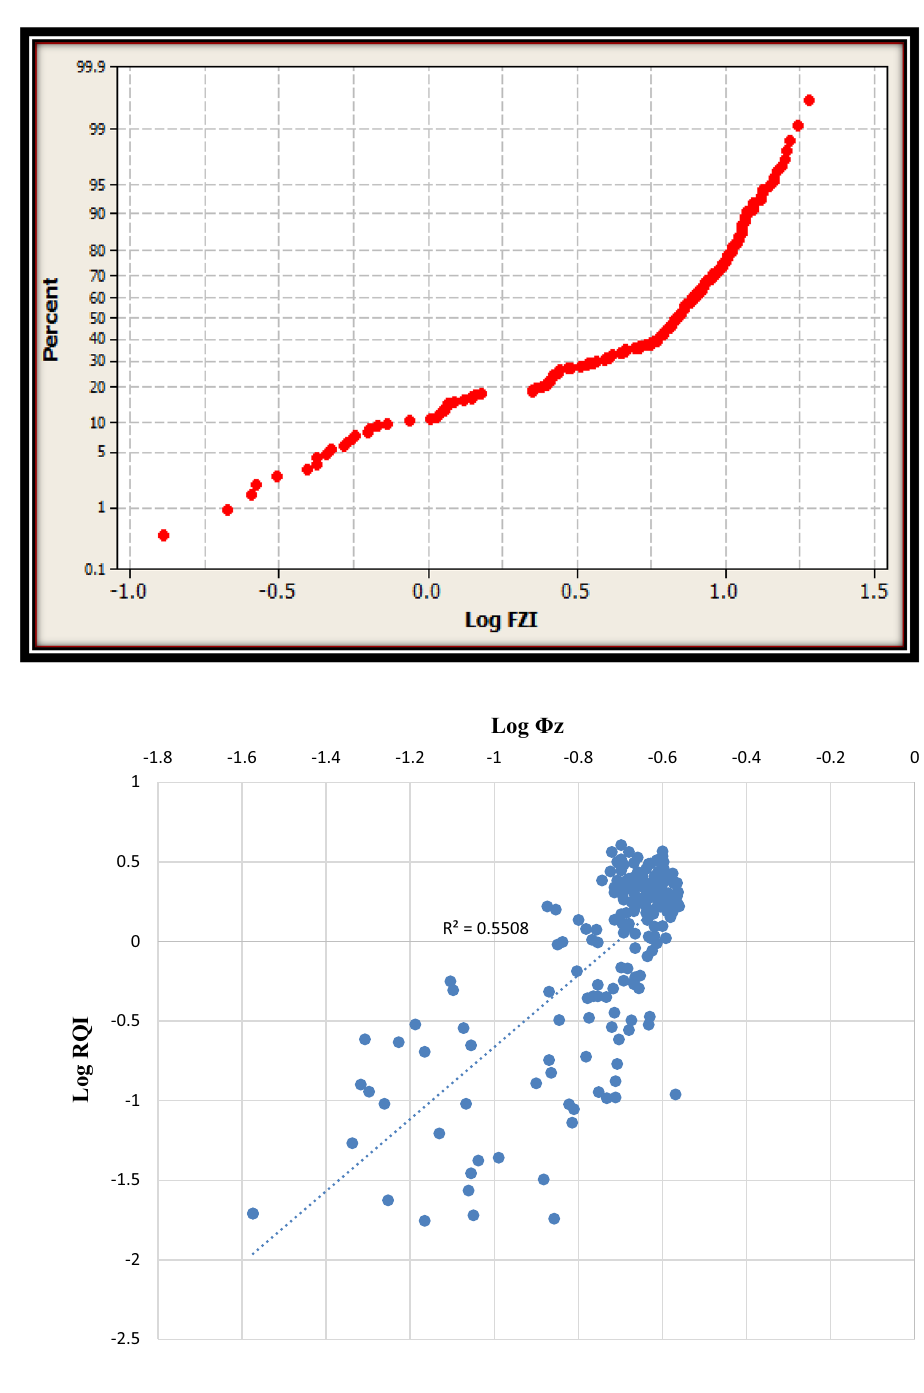
Fig. 6 Probability plot of log FZI of the studied cored wells